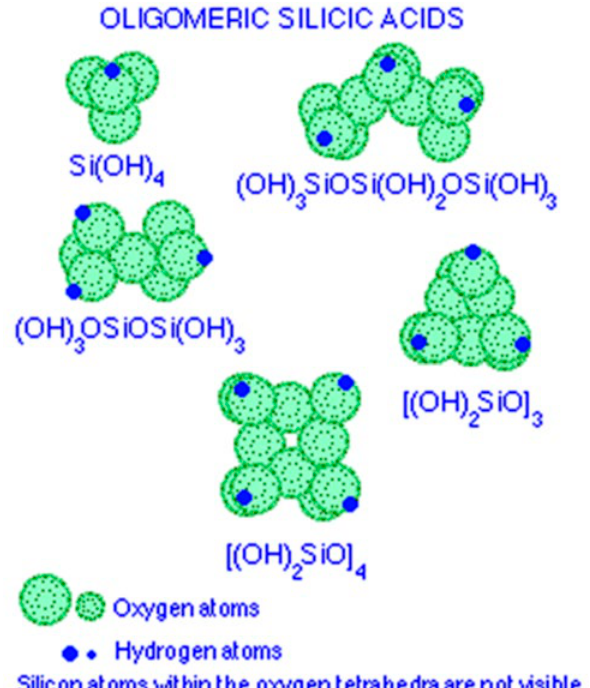
Figure 1. This diagram represents silicic acid molecules. The sphe- res represent oxygen atoms and the dots represent hydrogen atoms. Silicon atoms within the oxygen tetrahedra are not visible.